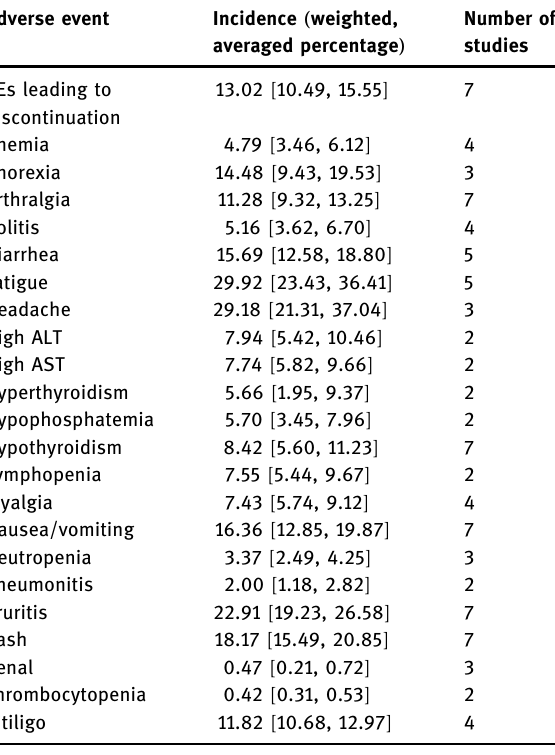
Table 2: Adverse events observed during pembrolizumab treatment reported by the included